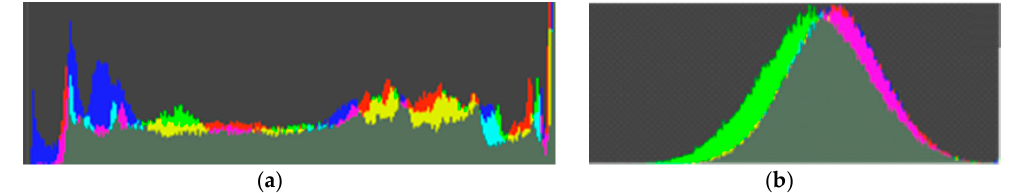
Figure 9. Color composition comparison for the proposed algorithm, and Sultana and Shubhangi’s algorithm [15]. Both frames are encrypted by performing 1920 permutations for rows and columns: ( a ) original video frame. The resolution is 1920 × 1080; ( b ) video frame encrypted with JLVEA. The frame has a different color composition than the original frame since the proposed algorithm separates color channels before permutation; ( c ) video frame encrypted with faro perfect algorithm. The frame’s color composition is similar to the original frame.